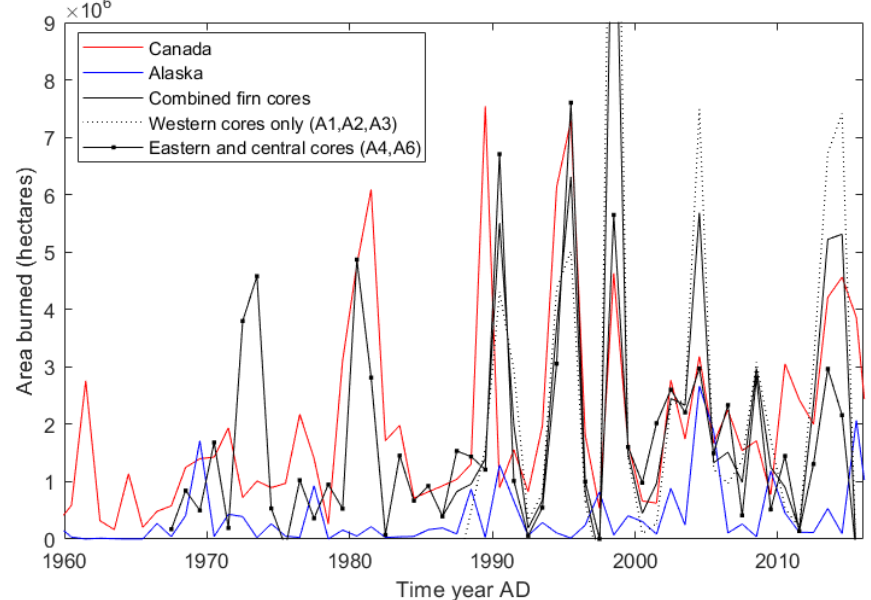
Figure 8. Forest fire composite (solid black line showing all records, dashed black line showing only western cores, and dots showing only eastern cores) compared to Canadian (in red; Parisien et al., 2012; Canadian Forest Service, 2013) and Alaskan (in blue) forest fire indexes (AICC, 2021; Legrand et al.,